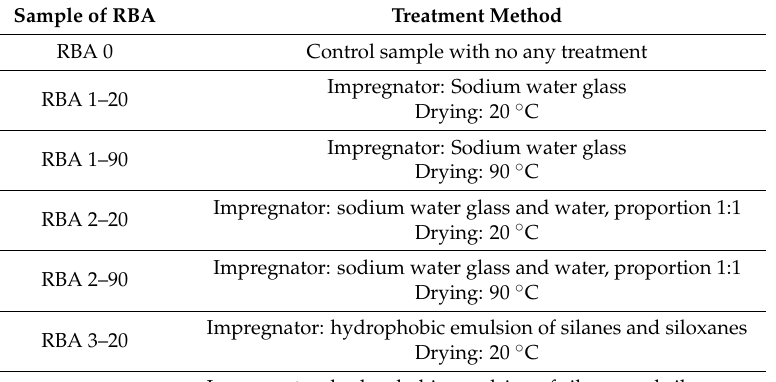
Table 1. Designation and description treatment methods of recycled brick aggregate (RBA).